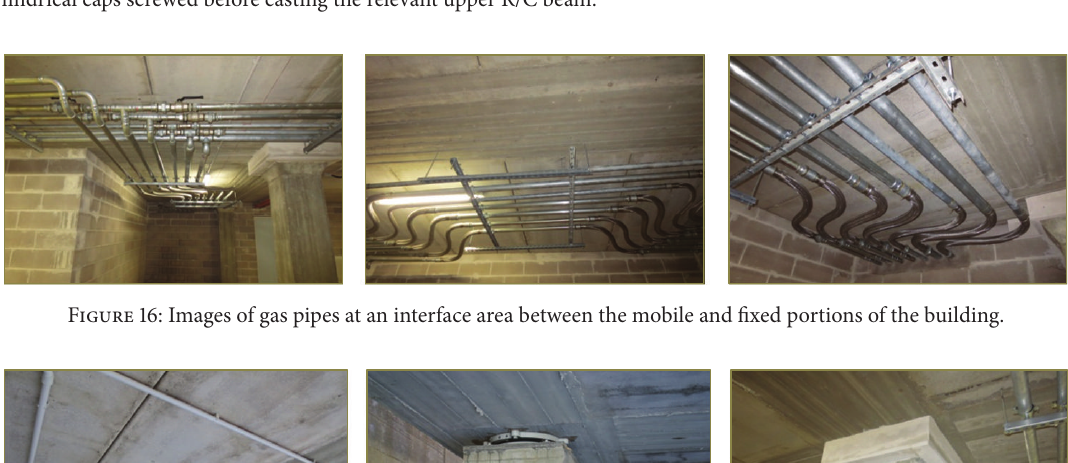
Figure 15: Images of the installation works of a DFP isolator placed below the bottom R/C slab of an elevator (left) and some isolators with the top cylindrical caps screwed before casting the relevant upper R/C beam.